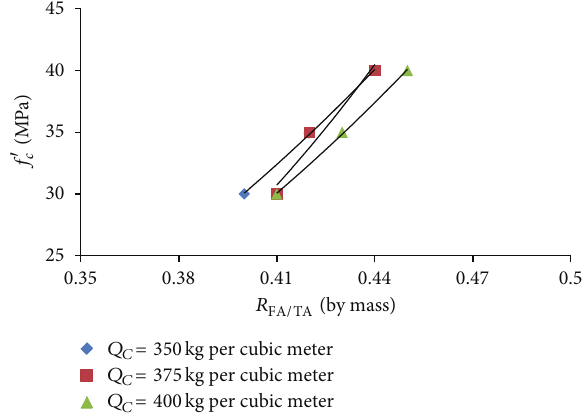
Figure 2: Variation of compressive strength 𝑅 of 𝑄 𝐶